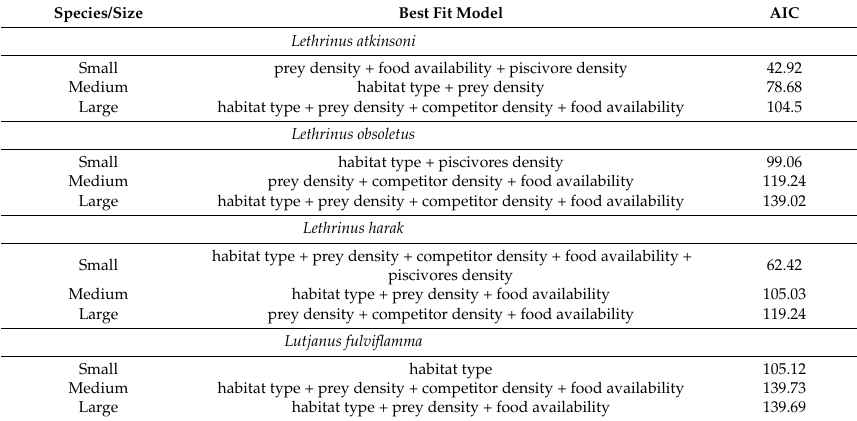
Table 5. The results of the generalized linear model (GLM) indicating the best fit model and the factors (habitat type, prey density, food availability, competitor density, and piscivore density) affecting the densities of the four target fishes across three different life history stages (small, medium, and large). AIC = Aikake’s information